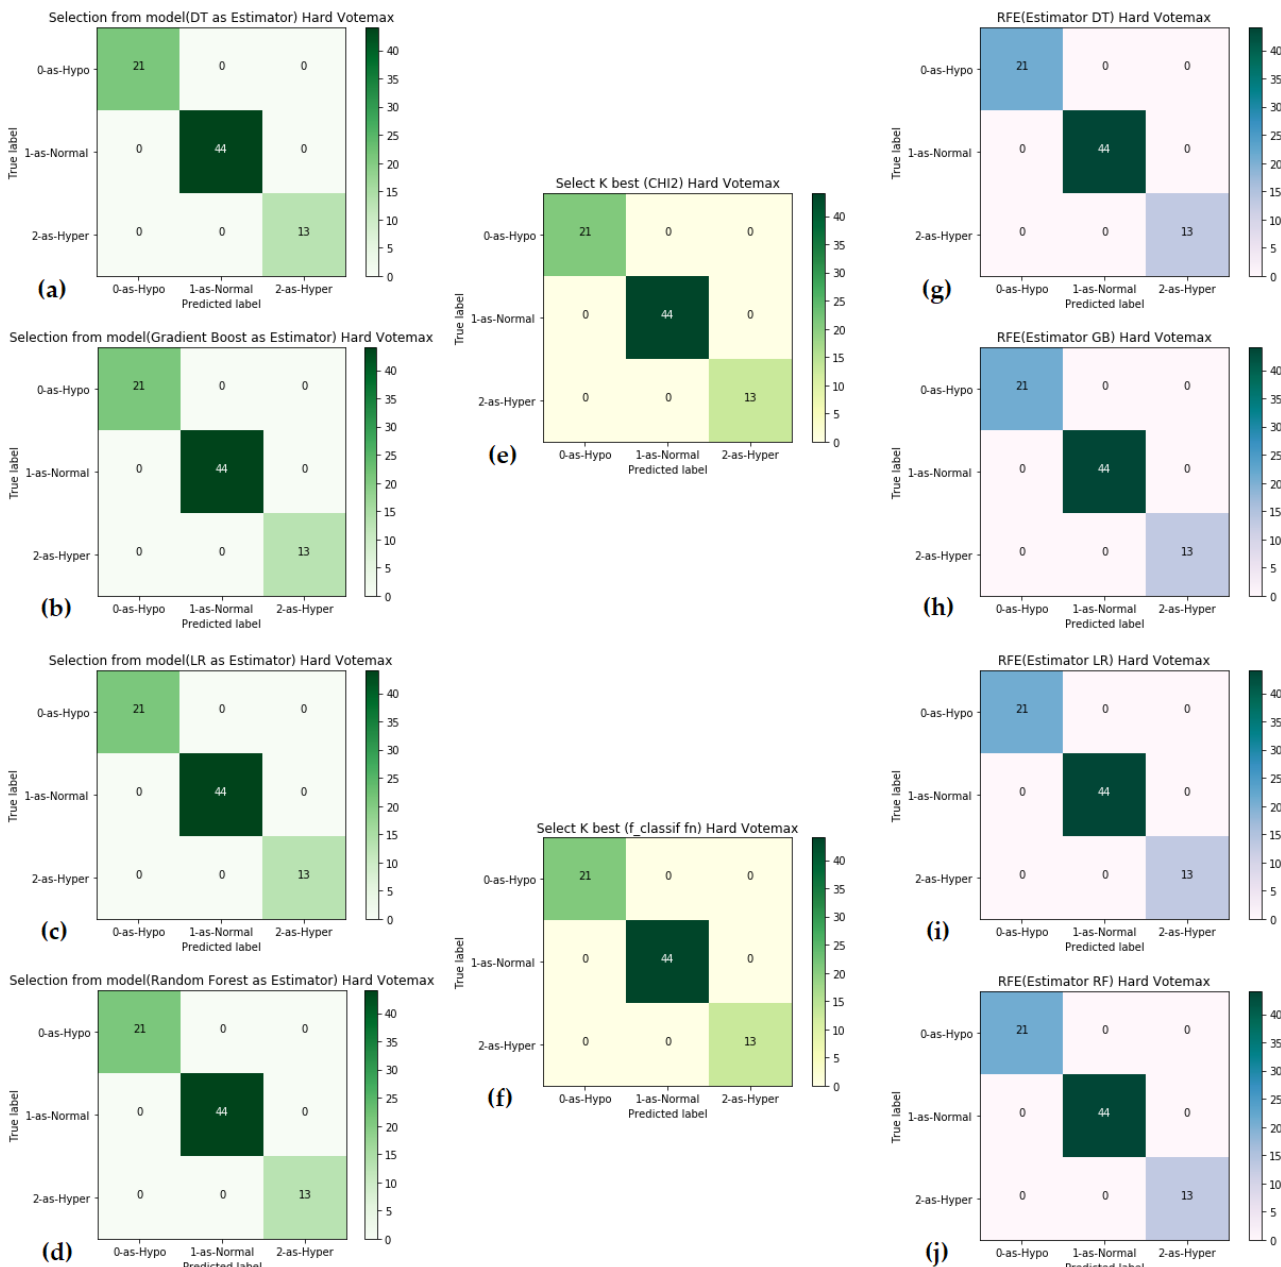
Figure 6. Confusion matrices for the hard voting ensemble of the bagging and boosting classifiers by implementing various attribute-selection methodologies with multiple estimators. ( a – d ) DT, GB, LR, RF estimators with SFM feature selection, ( e ) Chi2, ( f ) FCI with SKB feature selection, and ( g – j ) DT, GB, LR, RF estimators with RFE attribute selection, respectively.